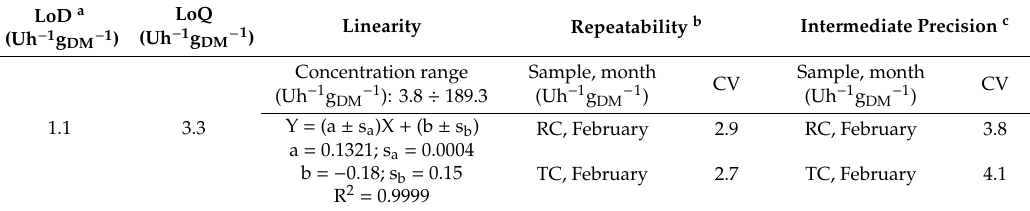
Table 4. Validation parameters for the determination of α -l-fucosidase activity in Fiore Sardo cheese. LoD a (Uh − 1 g DM − 1